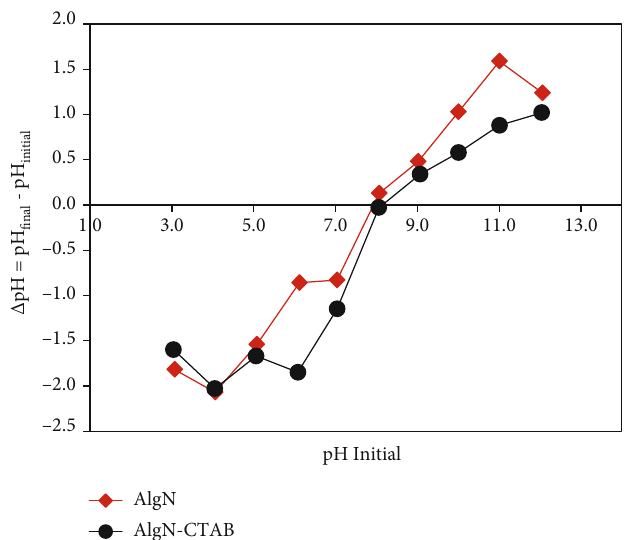
Figure 6: Investigation of pH